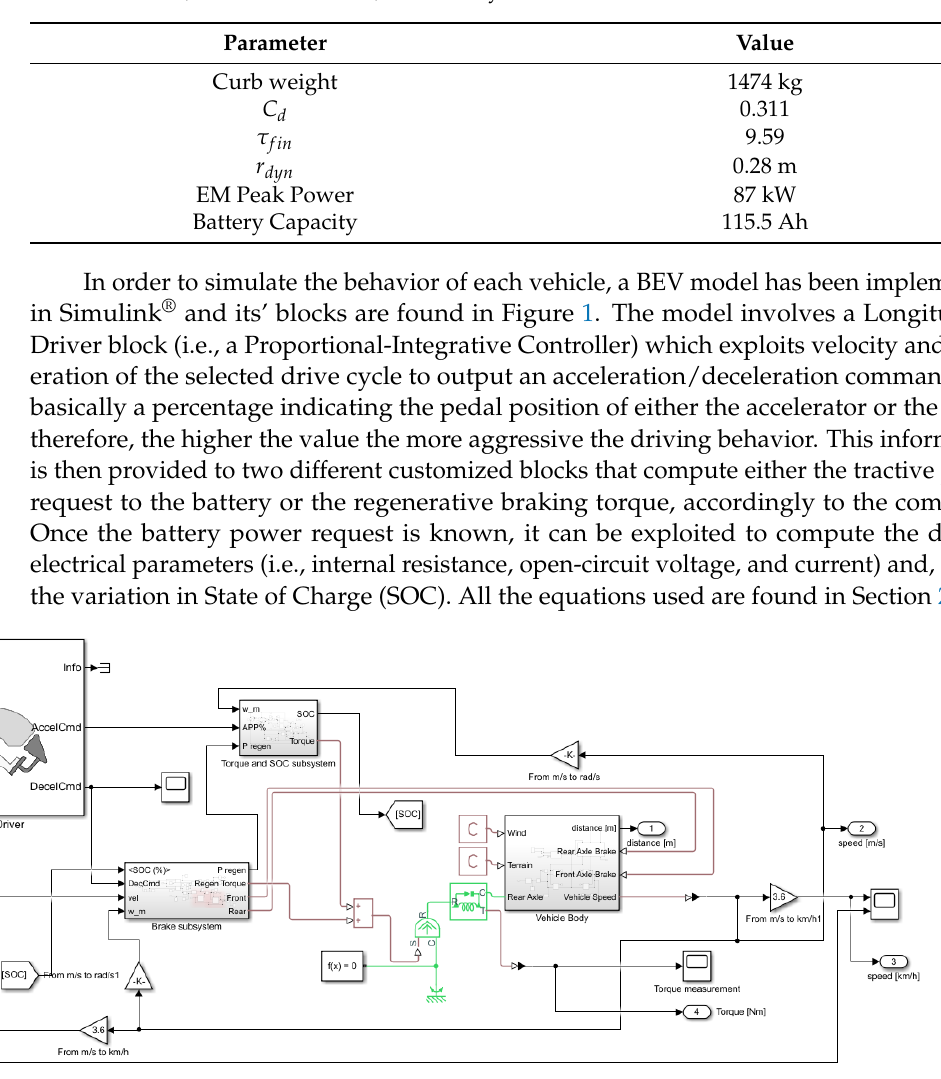
Table 1. Vehicle, electrical machine, and battery characteristics.